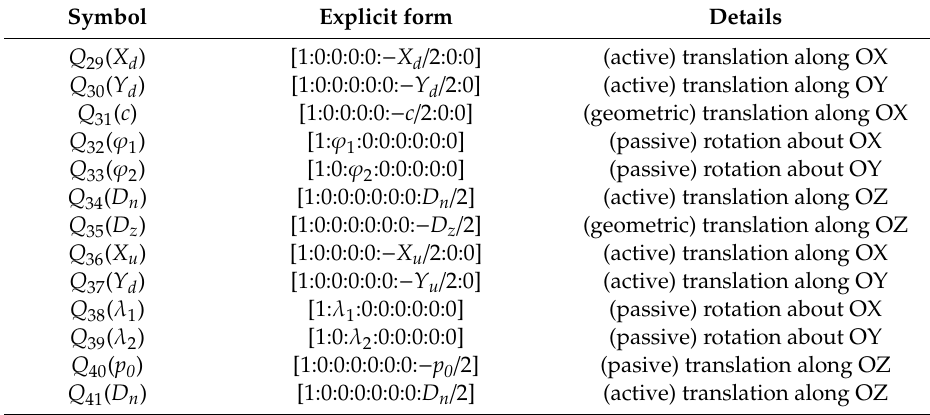
Table 4. The study parameters used in the motion parameterization of the mobile platform. Symbol Explicit form